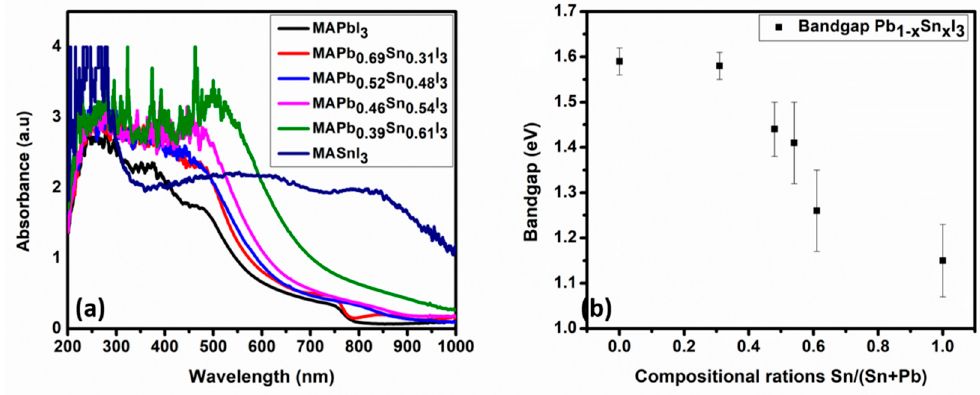
Figure 7. ( a ) UV-Vis absorption spectra of the perovskite films and ( b ) the E g evolution plot for different compositional ratios of Sn. The direct allowed bandgap transition values were obtained by extrapolating the linear portion of the ( α hv ) 2 versus hv plot, as depicted in Figure S5 in the support information. Table 3. Energy Bandgap and Urbach energy of binary metal perovskites.